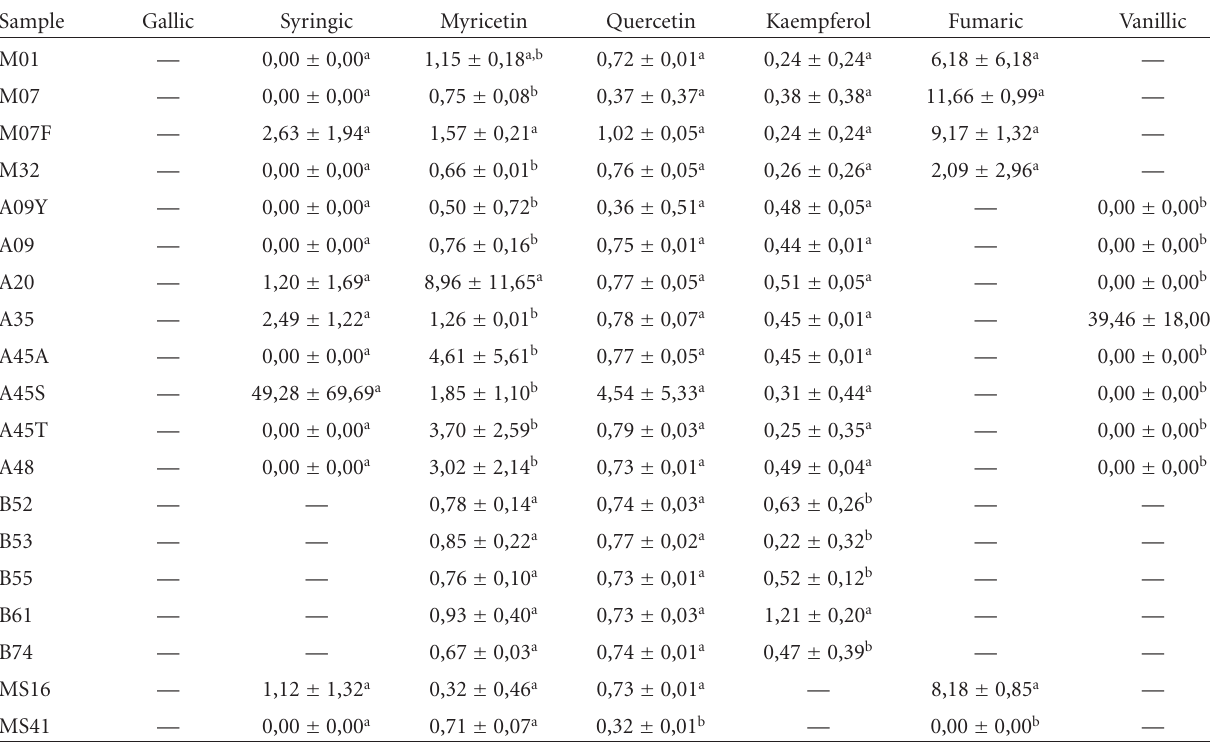
Table 4: Phenolic content of fresh nettle